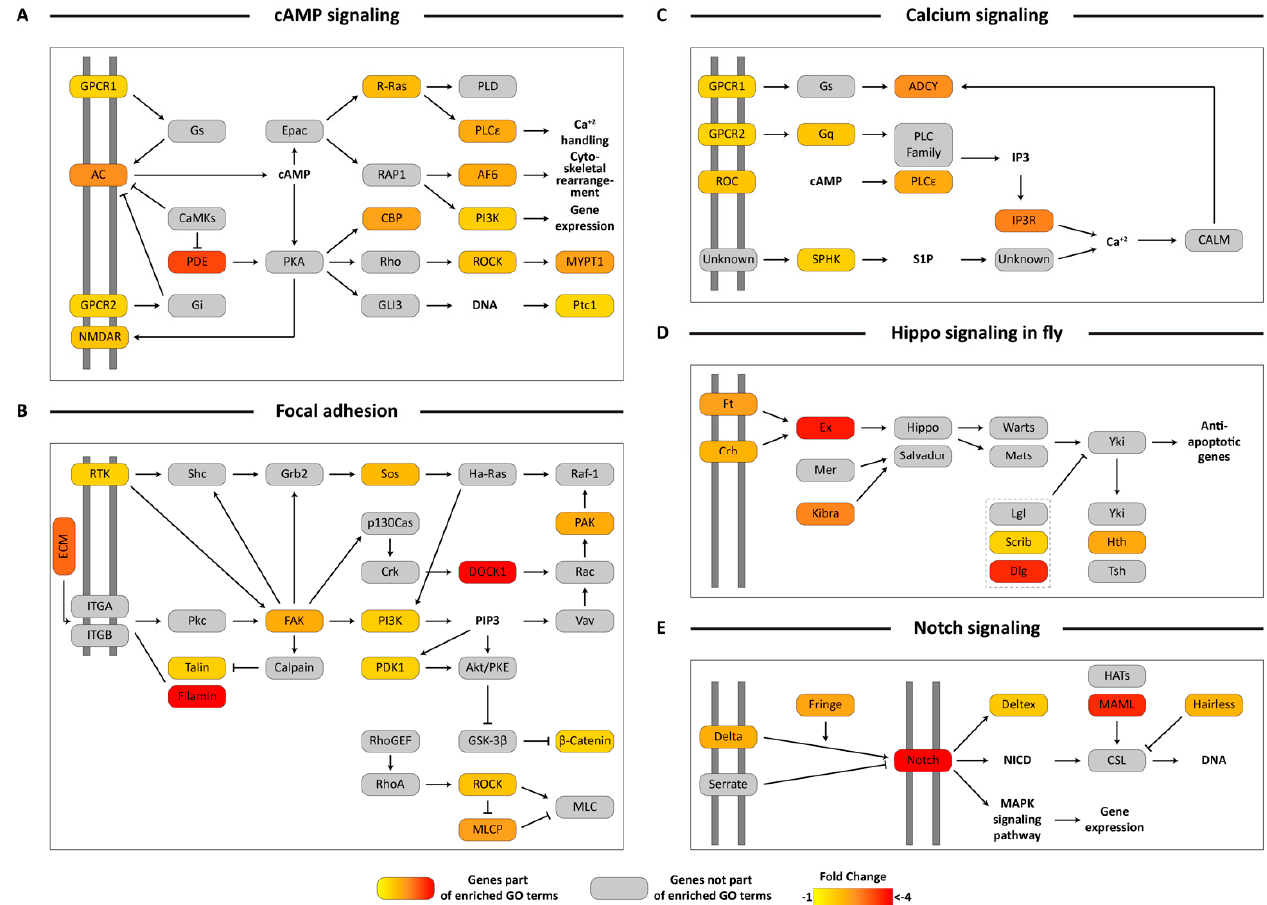
Figure 4. Pathway visualization using downregulated differentially-expressed unigenes in cAMP signaling, Focal adhesion, Calcium signaling, Hippo signaling in fly and Notch signaling. Transcripts from enriched Gene Ontology (GO) terms from the downregulated unigene set were mapped on to KEGG cAMP signaling ( A ), Focal adhesion ( B ), Calcium signaling ( C ), Hippo signaling in fly ( D ) and Notch signaling ( E ) pathways and visualized manually. Boxes in color represent protein coding genes that were present within the enriched GO terms. The gradient of the color represents their fold change. Grey boxes represent protein coding genes not present in the enriched GO terms. Pathway components present on double grey lines represent cell membrane receptors. Log 2 FC differences between the two conditions can be referenced in Table S2.